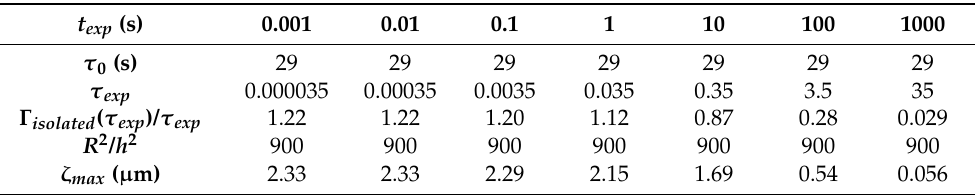
Table 5. Variation of the exposure time t exp for float glass, R = 600/2 mm and h = 10 mm.